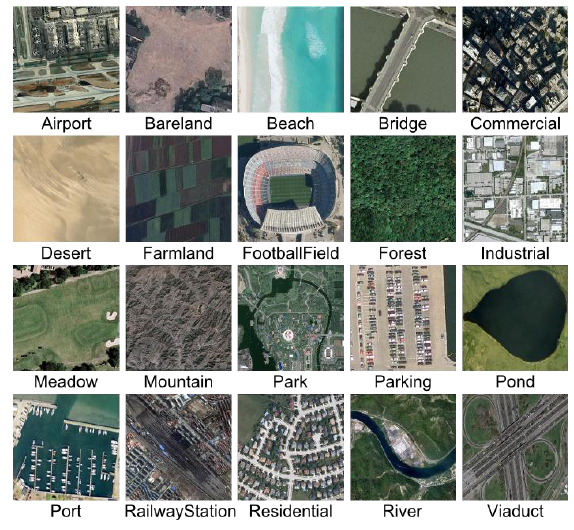
Figure 7. Examples of each category from the UCM dataset.